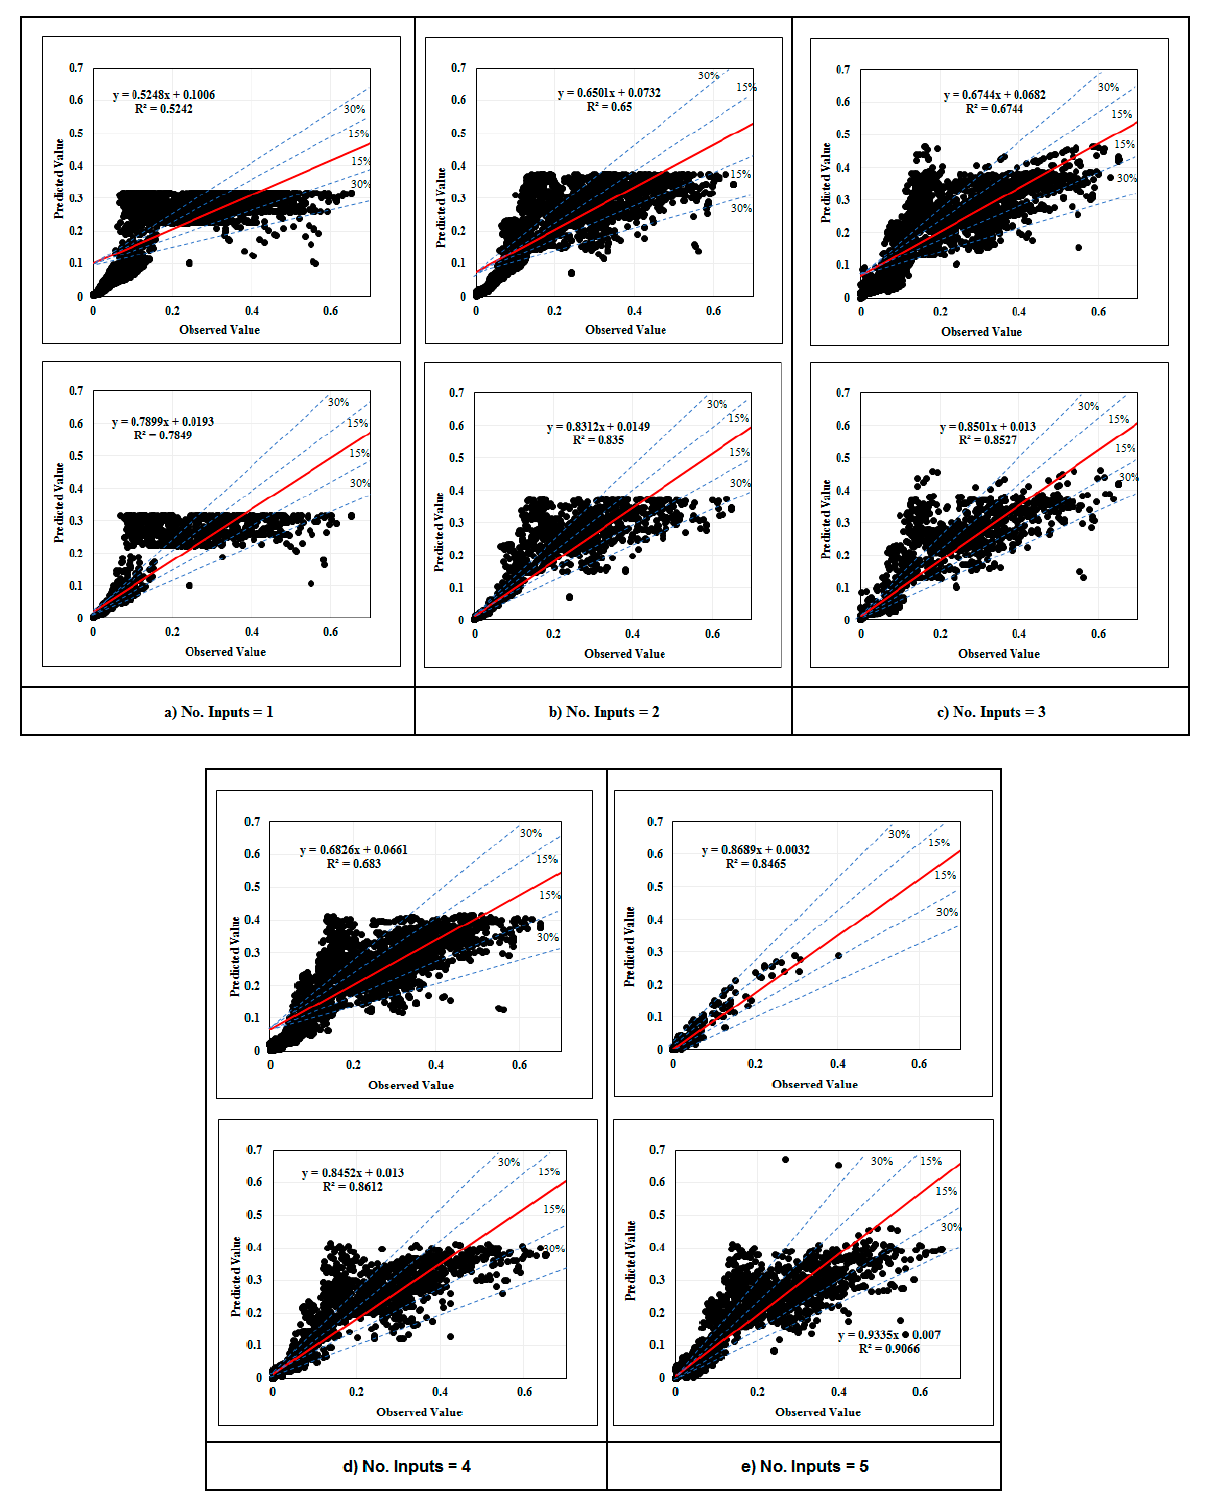
Figure 27. Regression of the training (above charts) and testing (below charts) phase results with measured values of normalised load for ( a ) one input, ( b ) two inputs, ( c ) three inputs, ( d ) four inputs, ( e ) five inputs.